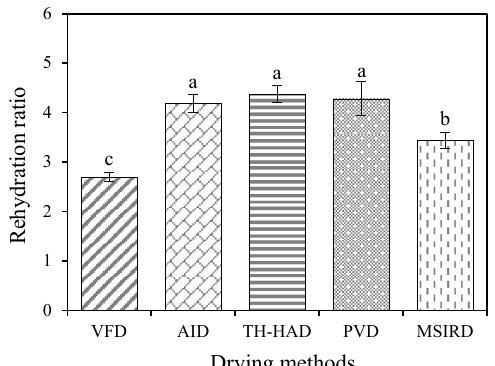
Figure 6. The rehydration ratios of dried garlic samples under various drying methods. The different letter (a–c) indicates statistically significant difference at p < 0.05.